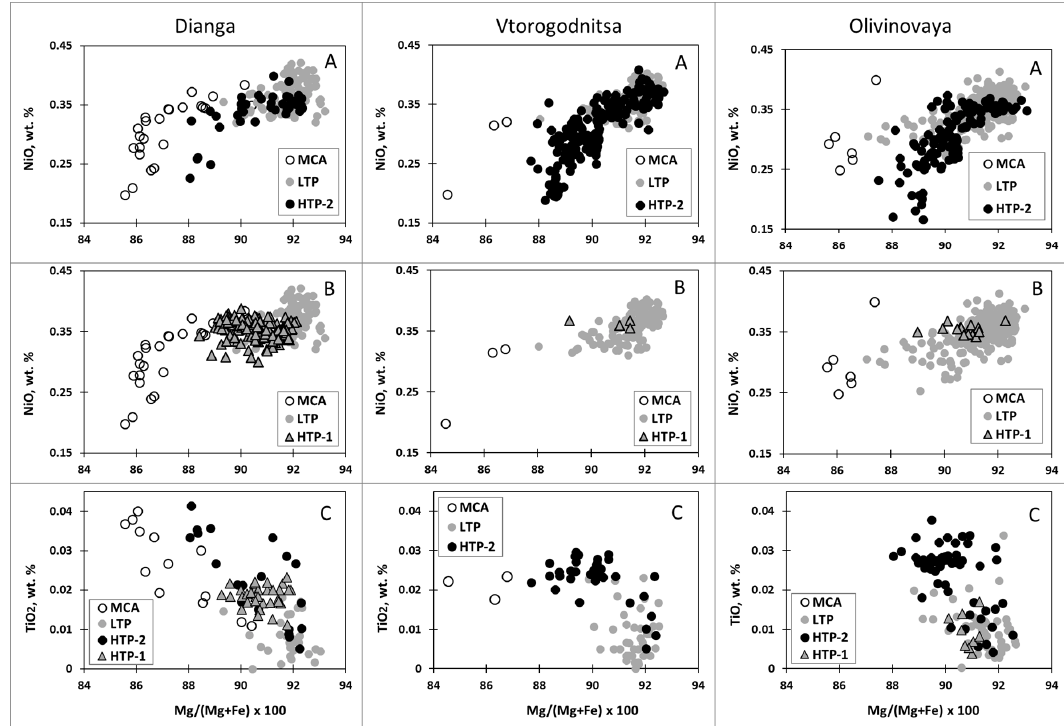
Figure 6. Distribution of olivines from kimberlites in northern Siberian craton. Olivine types: open circles = MCA, gray circles = LTP, black circles = HTP-2, triangles = HTP-1. Row ( A ) shows HTP-2 olivines in comparison to LTP and MCA; Row ( B ) shows the same for HTP-1; Row ( C ) define Mg#-TiO 2 for all types. First column—Dianga, second—Vtorogodnitsa, third—Olivinovaya kimberlites. See supplementary Table S1. Table 2. Composition variations in olivine groups distinguished according to texture and formation temperature of peridotite: granular or sheared, after work in [7,11] and LTP or HTP-1 + HTP-2 (this study), respectively. HTP-1 and HTP-2 are two subtypes of high-temperature peridotites and belong to one group.